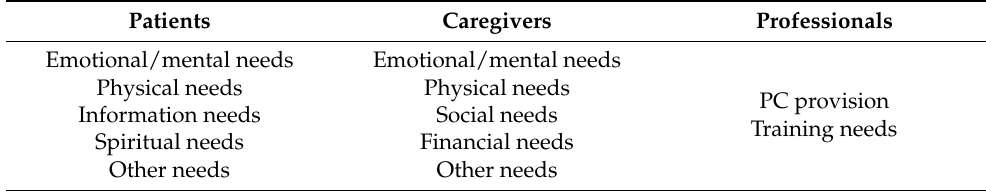
Table 2. Final topics according to the WHO’s PC definition.